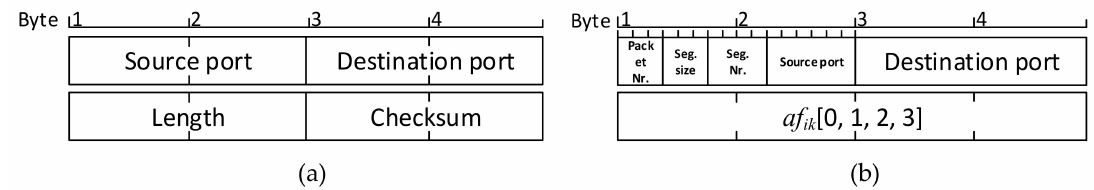
Figure 3. Proposed modifications to the User Datagram Protocol (UDP) packet’s header. Standard UDP header ( a ) and modified header ( b